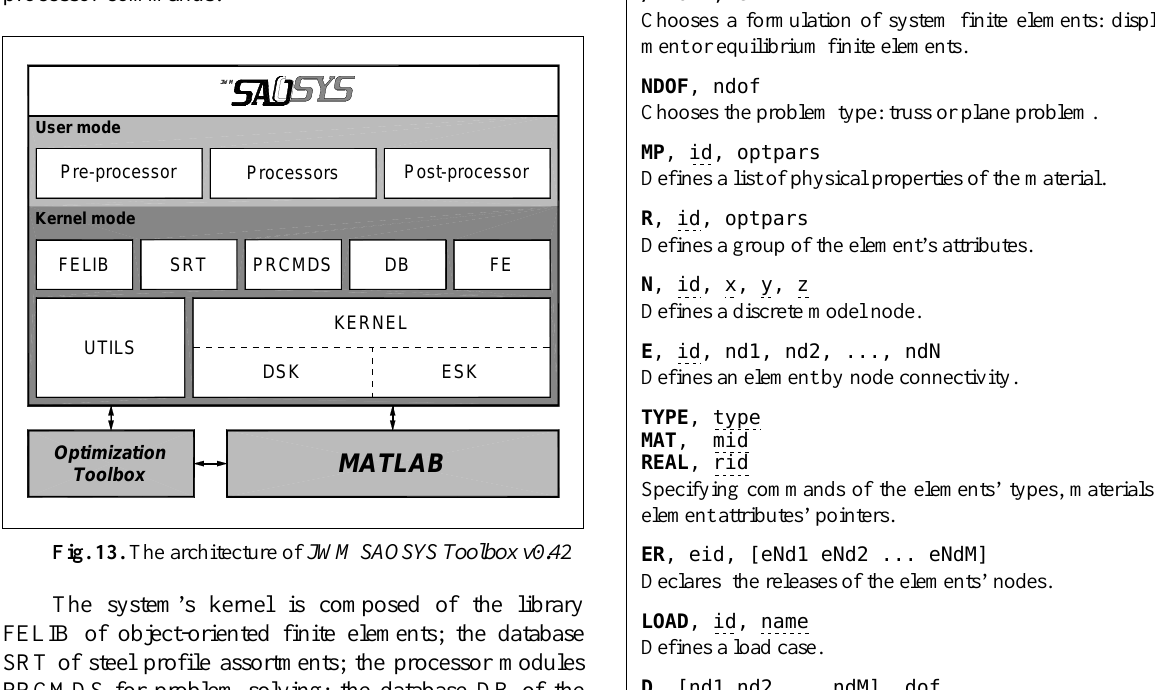
Table 2. SAOSYS pre-processor commands /TITLE , title Defines the main problem title. /EFORM , ef Chooses a formulation of system finite elements: displace- ment or equilibrium finite